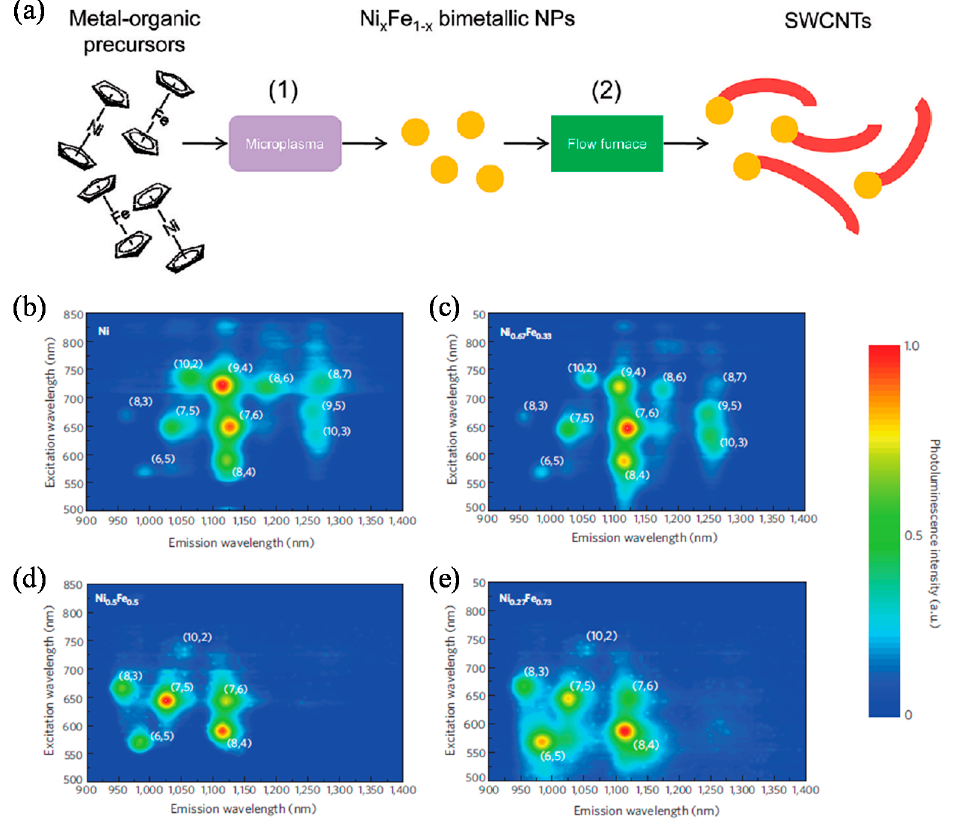
Figure 13. ( a ) Stepwise, a gas-phase process for SWCNTs growth consisting of (1)